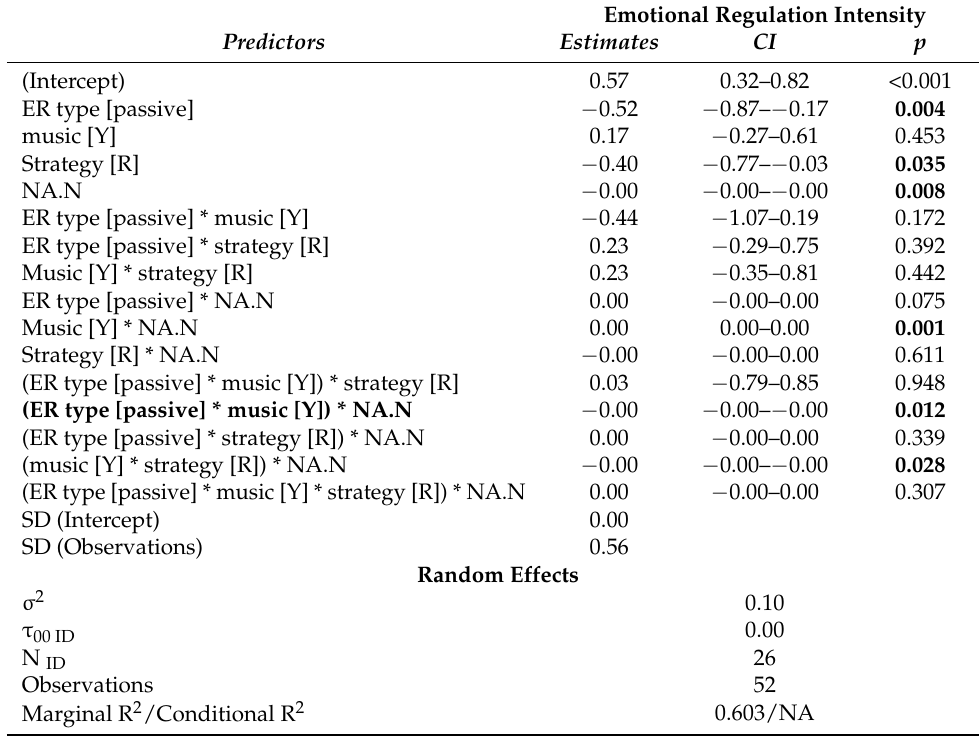
Table A6. Higher DS (higher working